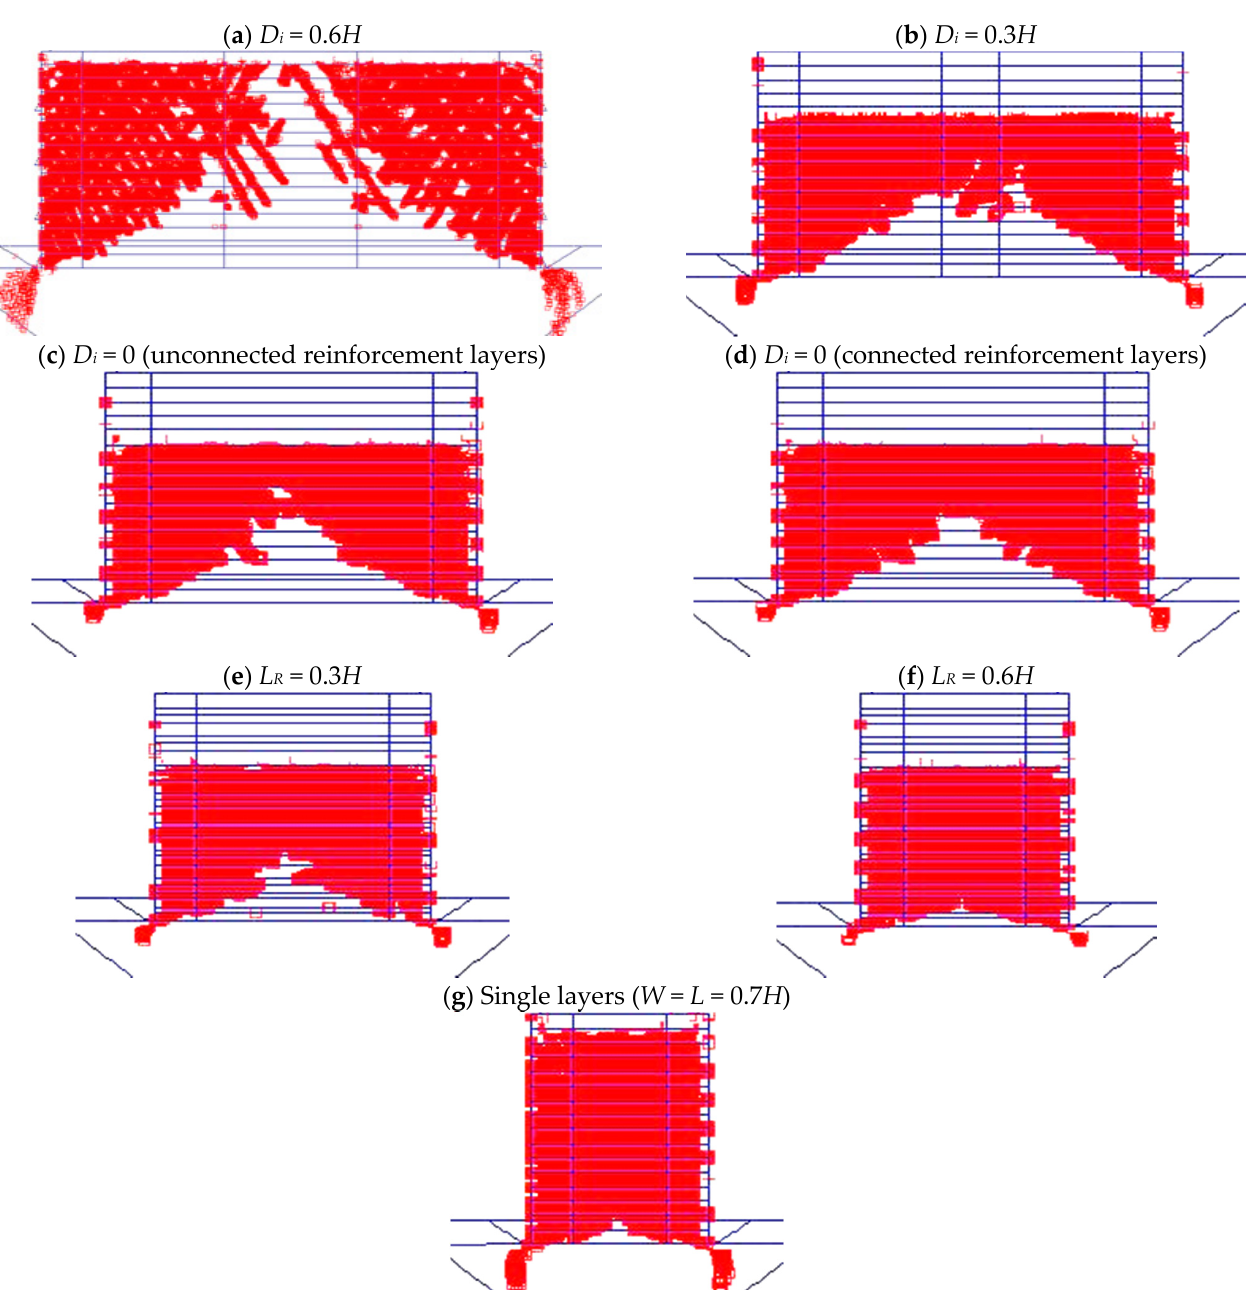
Figure 10. Plastic zones (Mohr–Coulomb points) in the soil at the end of construction (EoC) for walls with different interaction distances. ( D i ) between the back of the reinforced soil zones for opposite walls. (Note: white zones on top of the models represent the location of tension cut-off points). Numerical results for horizontal pressures at different cross-section plane distances from facing panels, and calculated values of total horizontal stress from the Rankine coef- ficient of active earth pressure ( K a ) and the coefficient of earth pressure at rest ( K 0 ), at fac- ing, at 1 m from facing, and behind the reinforcements (i.e., at L -distance from facing), are plotted in Figures 12–14, respectively. It is noted that the numerical results for lateral earth pressure at facing (Figure 12) are lower than the analytical ones. The closest agreement is obtained with the active Rankine lateral earth pressure when the interaction distance is large (i.e., D i = 0.6 H and D i = 0.3 H ) except for the upper half-height for single layers case (because it creates an unyielding structure creating an at-rest stress state ( K 0 ) from the top